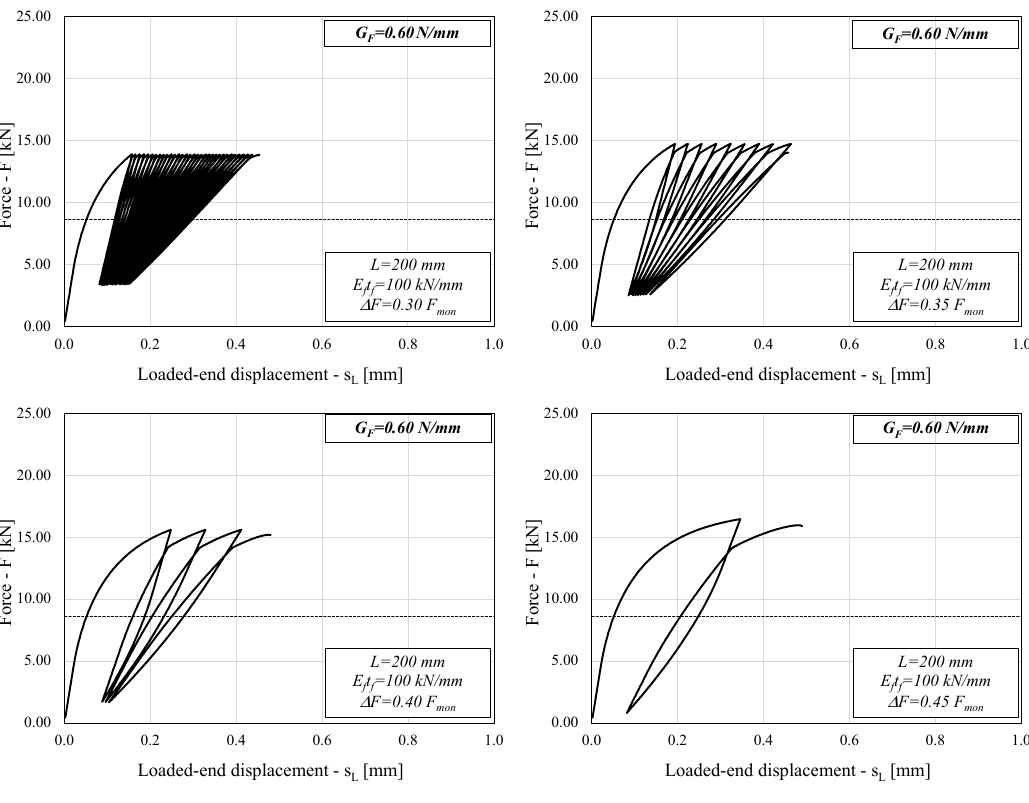
Figure 3. Load–slip curve (L = 200 mm, G F = 0.60 N/mm).